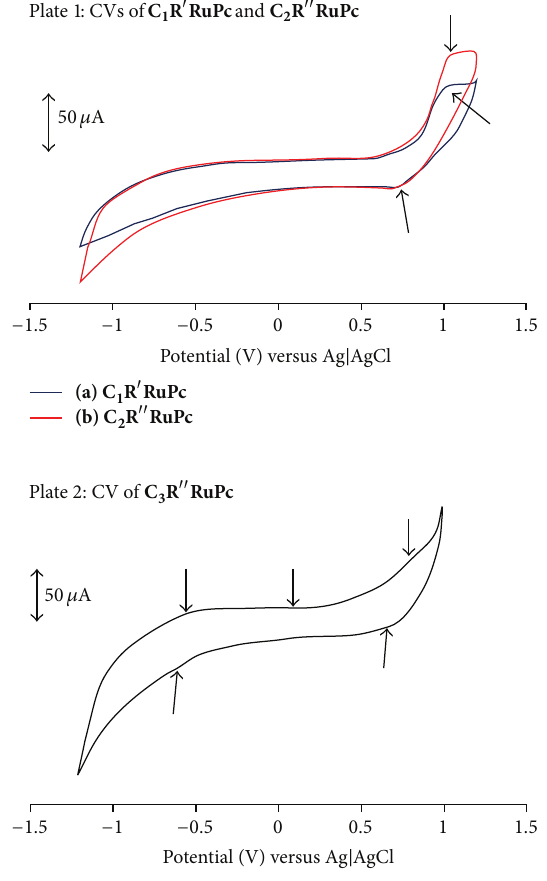
Figure 7: Cyclic voltammetry of ( C 1 R 󸀠 RuPc ), ( C 2 R 󸀠󸀠 RuPc ), and ( C 3 R 󸀠󸀠 RuPc